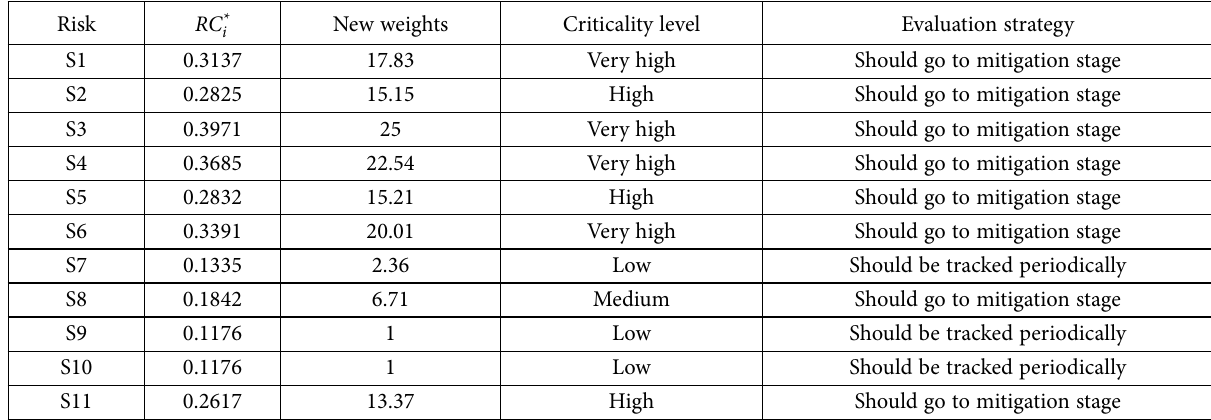
Table 8. Proposed evaluations with respect to the analysed risks using interpolation